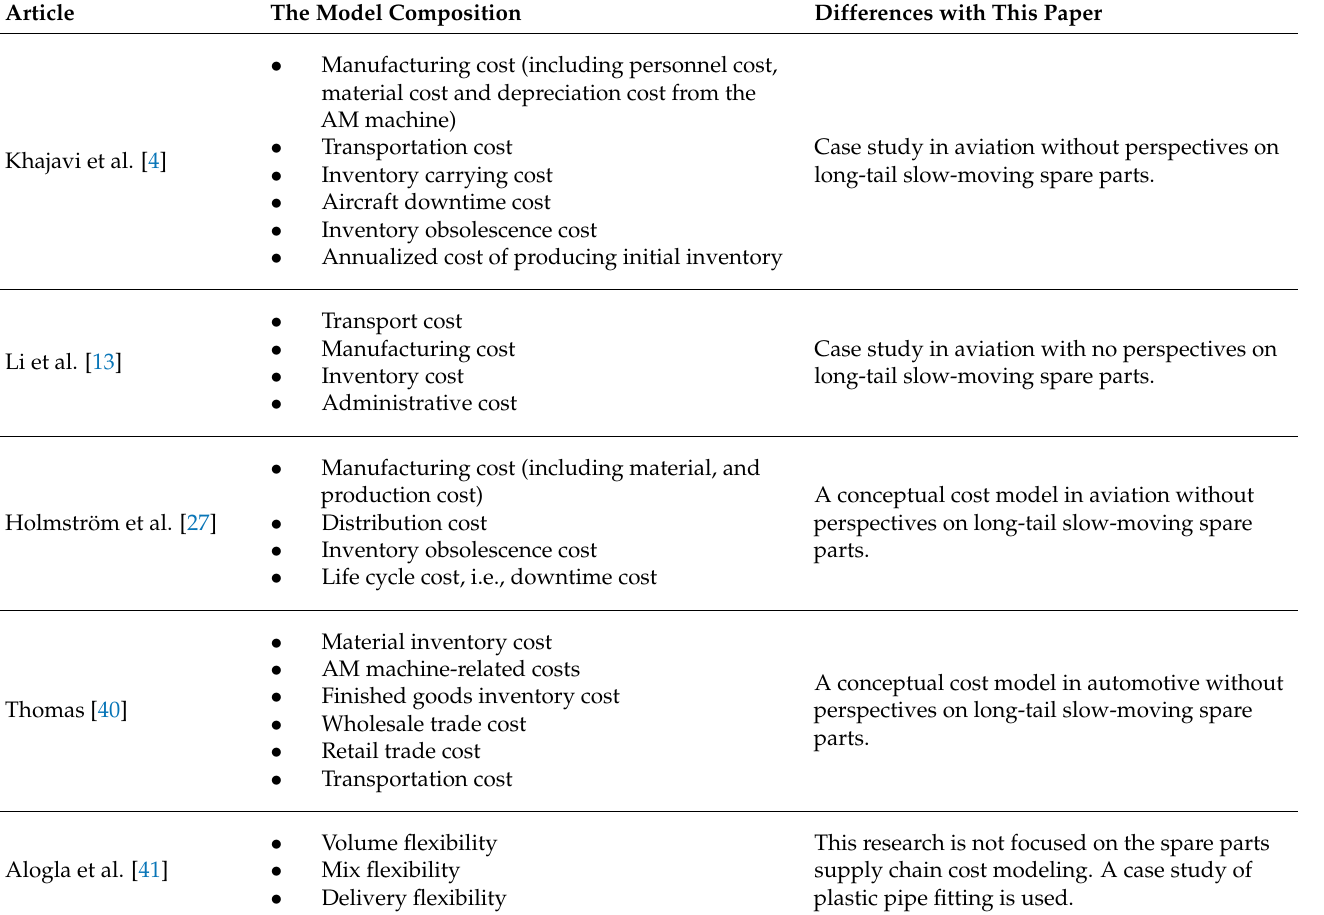
Table 1. AM SPSC cost